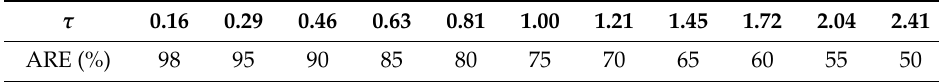
Table 1. Asymptotic relative e ffi ciency (ARE) values of the probability integral transform statistic (PITS) estimator and corresponding tuning parameter τ